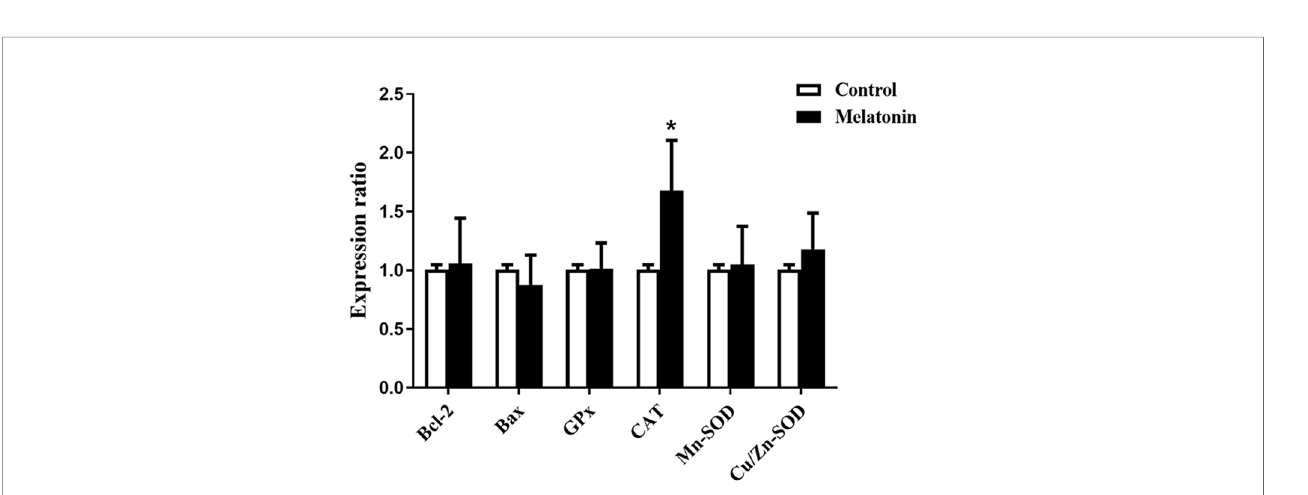
FIGURE 3 | Effects of melatonin on the gene expression of BCL-2, BAX, CAT, GPX1, Mn-SOD and Cu/Zn-SOD in vitri fi ed-warmed human cleavage-stage embryos cultured for 72 h. * P < 0.05 compared with the control group.